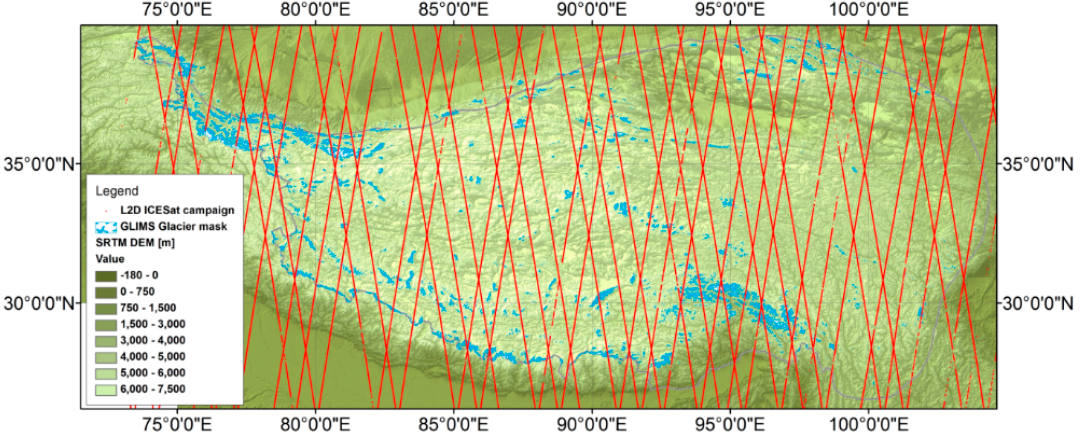
Figure 1. GLIMS glacier outlines and ICESat L2D-campaign tracks superimposed on the SRTM DEM over the Tibetan Plateau.